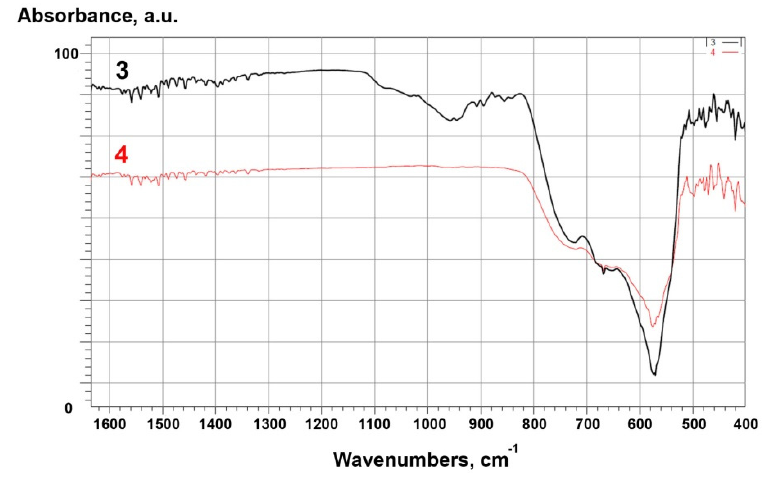
Figure 7. FTIR spectra for: 3 – ZrO 2 _2 (modified), 4 – ZrO 2 _1 (raw).